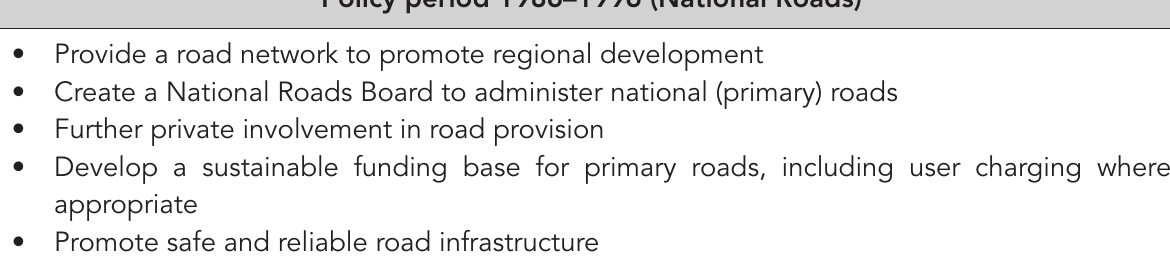
Table A5: Government policy objectives for the 1996–2006 policy